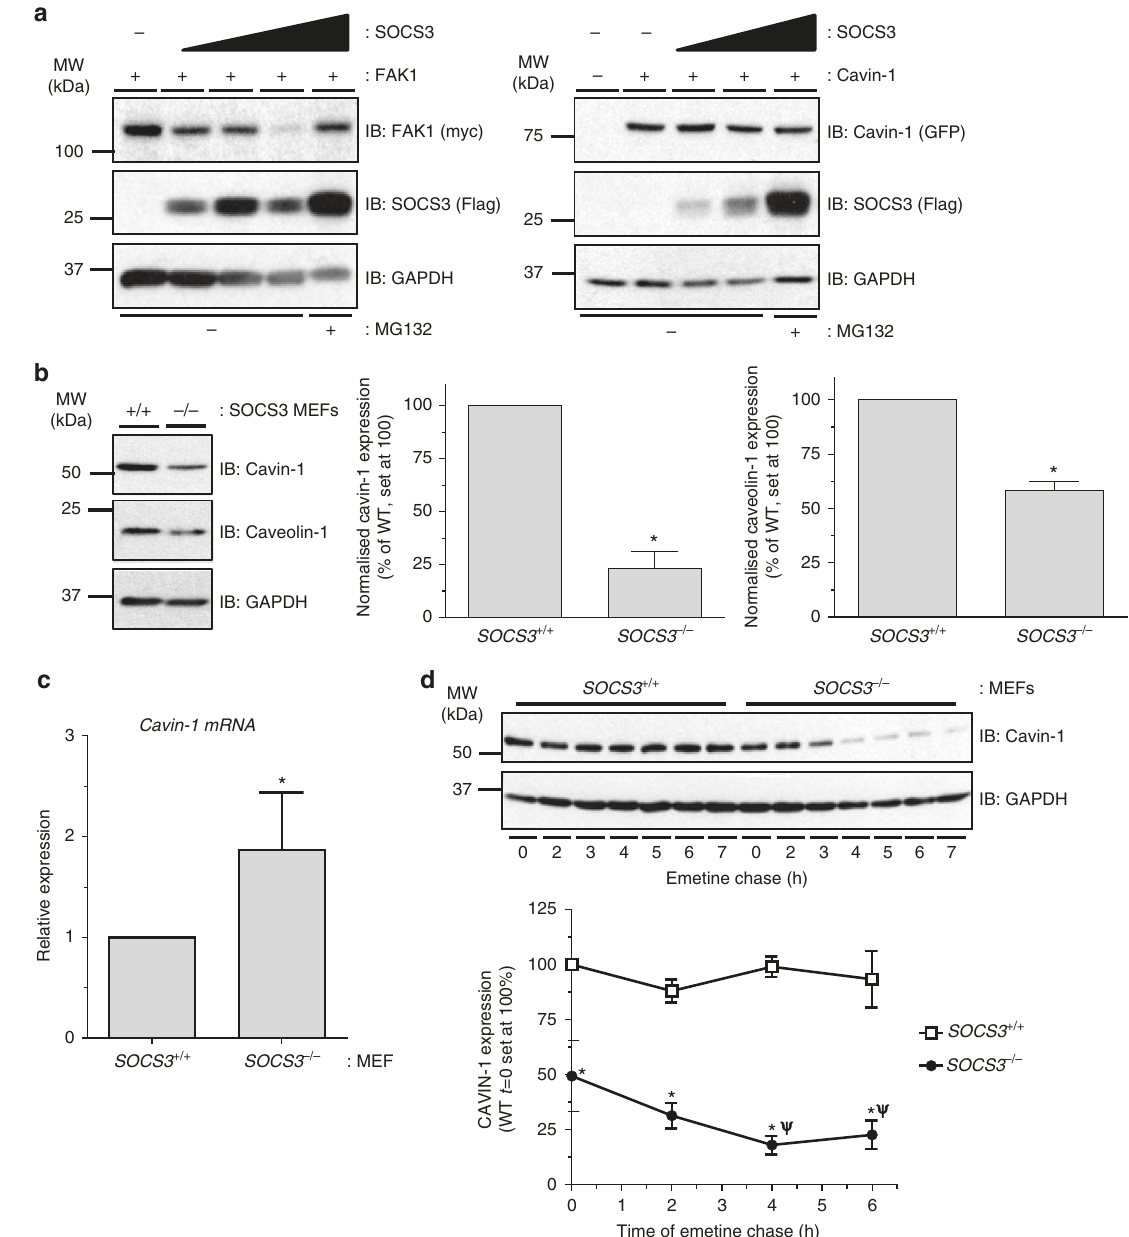
Fig. 1 Cavin-1 stability is enhanced in the presence of SOCS3. a HEK293 cells co-transfected with fi xed amounts of either myc-tagged FAK1 or GFP-cavin-1 expression constructs and increasing levels of Flag-SOCS3 were treated with or without proteasome inhibitor MG132 (6 μ M) as indicated. Detergent- soluble whole-cell lysates were analysed by SDS-PAGE and immunoblotting. b Detergent-soluble whole-cell lysates prepared from SOCS3 + / + (+/+) and SOCS3 − / − ( − / − ) MEFs equalised for protein content were analysed by SDS-PAGE and immunoblotting. c Quantitative real-time PCR of cavin-1 mRNA levels in WT ( SOCS3 + / + ) and SOCS3 − / − MEFs. Data are presented as mean ± standard error for N = 3 experiments. d Upper: Protein-equalised soluble cell extracts from SOCS3 + / + and SOCS3 − / − MEFs chased for the indicated times in serum-free medium with protein synthesis inhibitor emetine (100 μ M) were analysed by SDS-PAGE and immunoblotting with the indicated antibodies. Lower: Quantitation of cavin-1 levels in SOCS3 + / + and SOCS3 − / − MEFs is also shown. Results are presented as mean values ± standard error for N = 3 experiments. * P < 0.05 vs. corresponding treatment in SOCS3 + / + MEFs, ψ P < 0.05 vs. t =